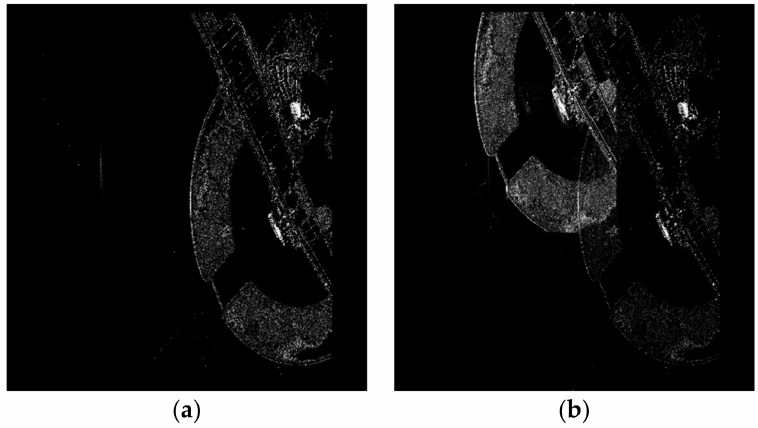
Figure 11. A scene target image, ( a ) target image without RDJ; ( b ) target image with RDJ.